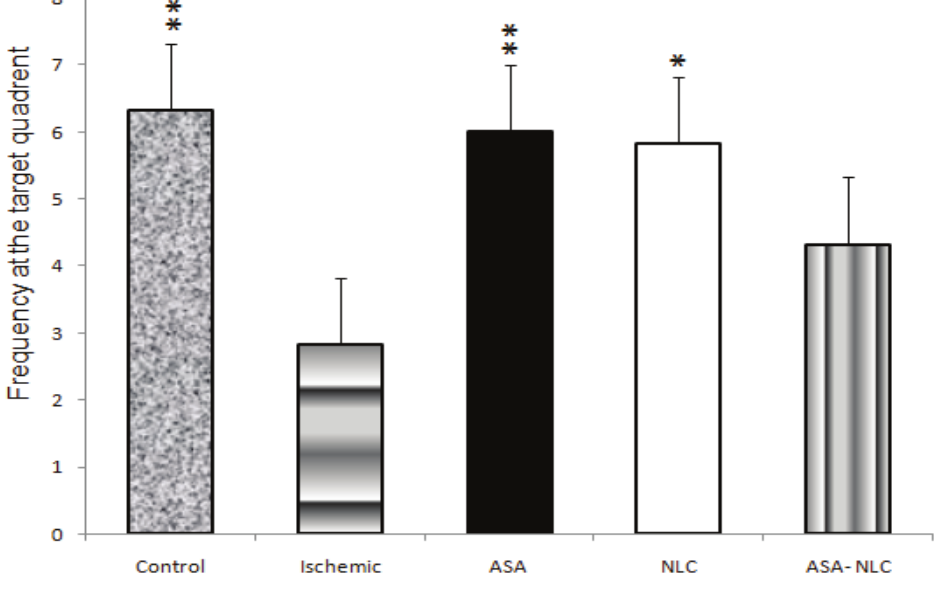
Figure 3: Ischemic animals significantly reduced the frequency of entrance to the target quadrant compared with the control animals. It was higher in the ASA and NLC groups compared with the ischemic animals. The frequency of entrance at target zone also decreased in ASA- NLC group. *, p ≤ 0.05; **, p ≤